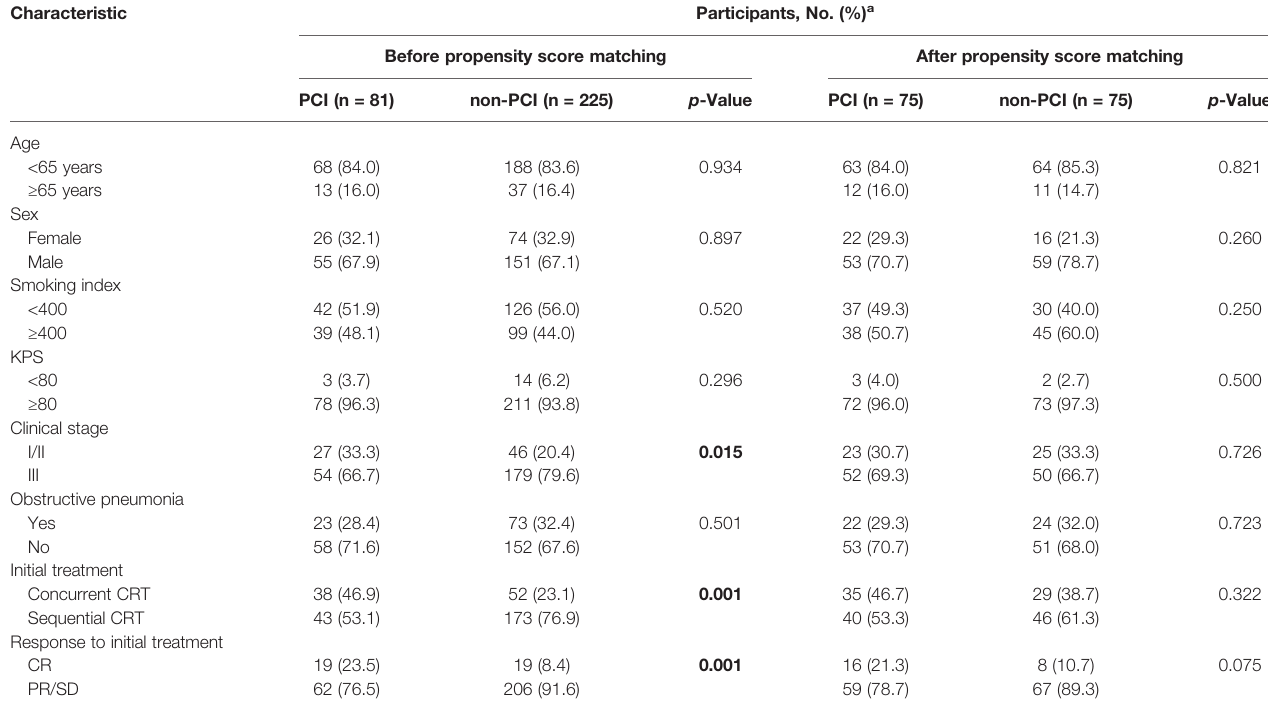
TABLE 1 | Descriptive characteristics before and after propensity score